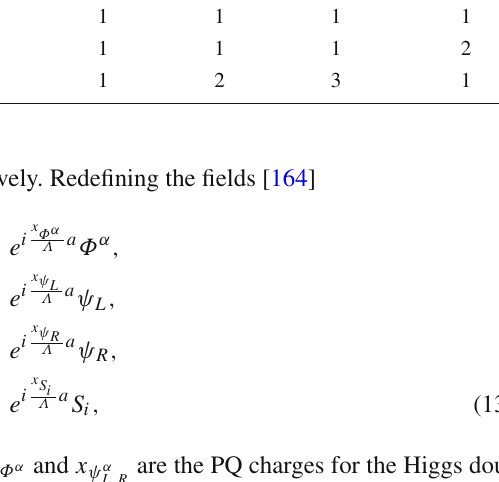
in each family. PQ charges are shown for the SM left-handed quarks x q i